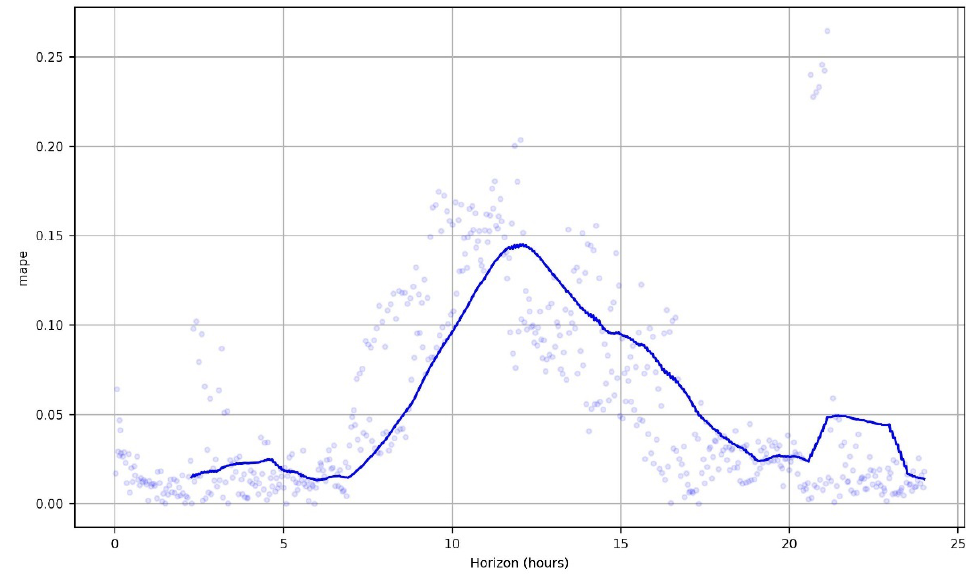
Table 2. Error metrics for the humidity variable.